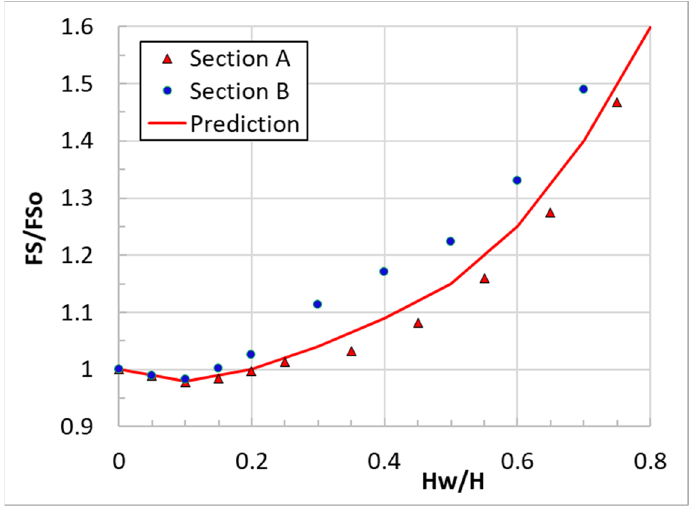
Figure 14. Variation of the safety factor (FS) of Sections A and B, against slope instability with pit lake water depth (H w ). The safety factor (FS) is normalized with the initial safety factor (FS o ) of the same slope when H w = 0. H is the total slope height. The curve “Prediction” plots an average curve of the two Sections that can be used for preliminary predictions.